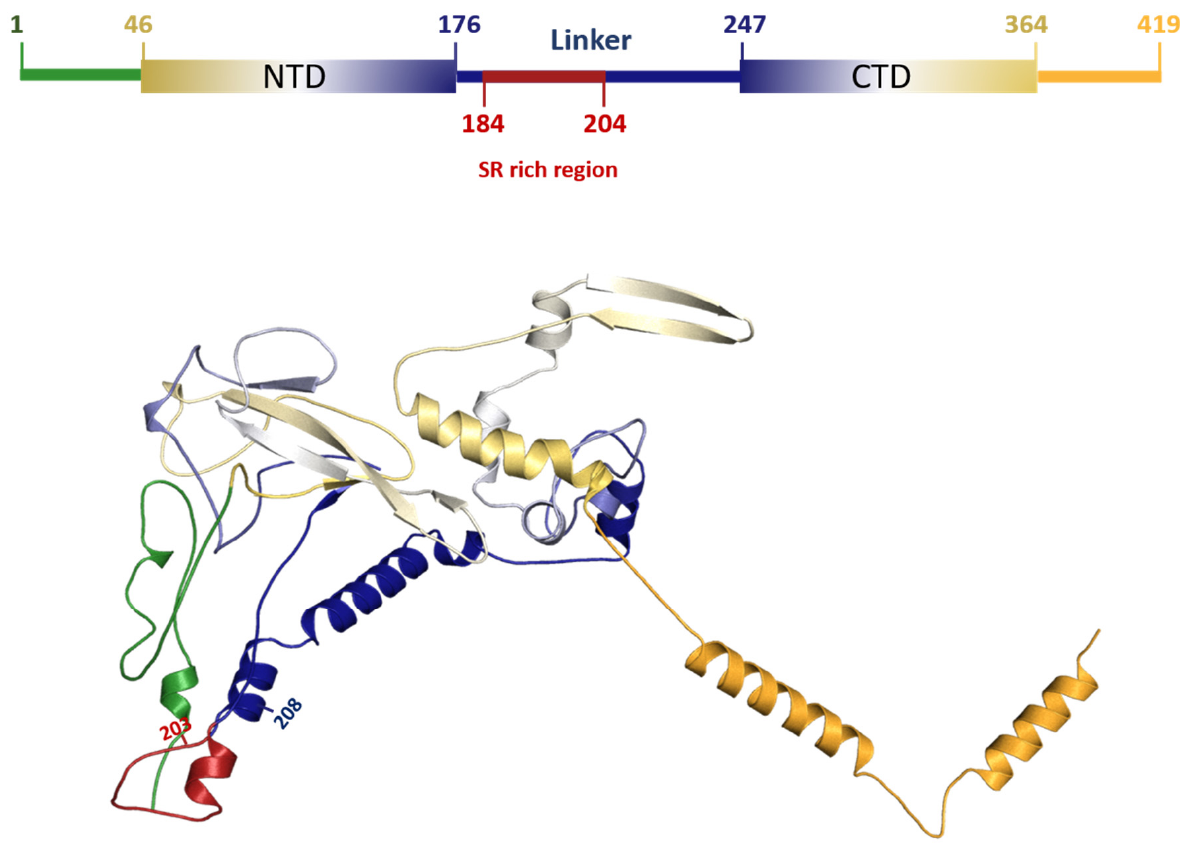
Figure 2. Representative model of protein N indicating the region of the 203–208 deletion, generated by the Robetta server and using the software PyMOL for image generation. The generated model is in compliance with previous work suggesting that the NTD and CTD minimally interact to each other, if at all. They are separated by the linker that is partially extended and with disordered regions have transient α -helices [6–9]. Deletion of the 203–208 fragment will alter physico-chemical properties that might impact on protein mobility between N- and C-terminal domains, as well as in the RNA-mediated phase separation process.